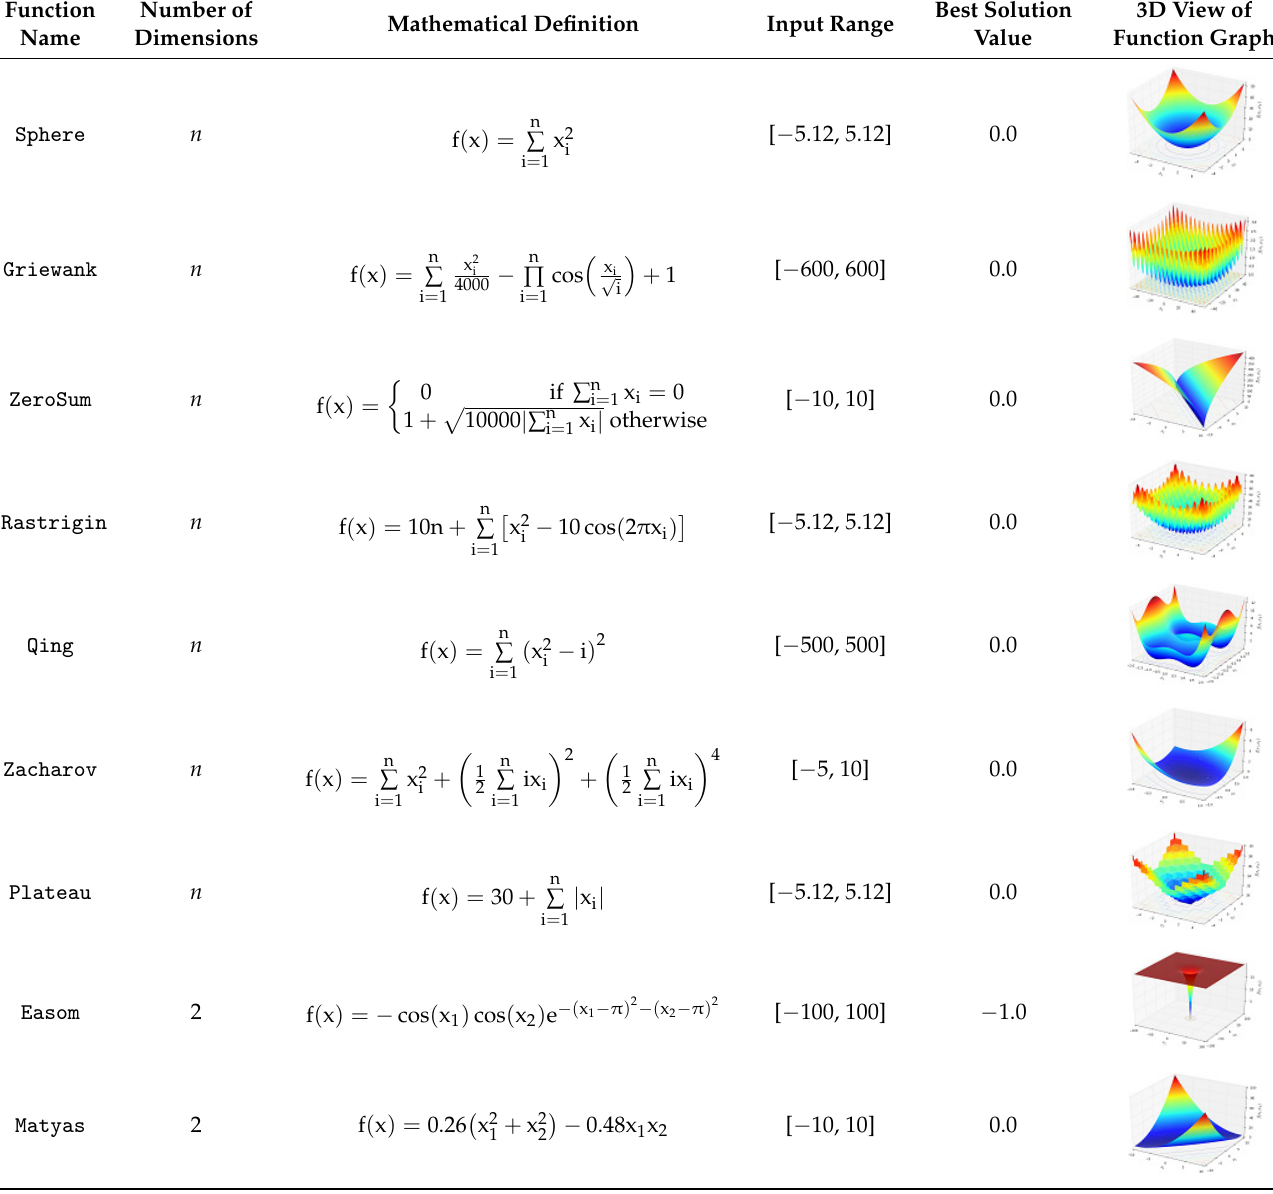
Table 2. List of selected continuous mathematical functions for evaluating the CGM algorithm.